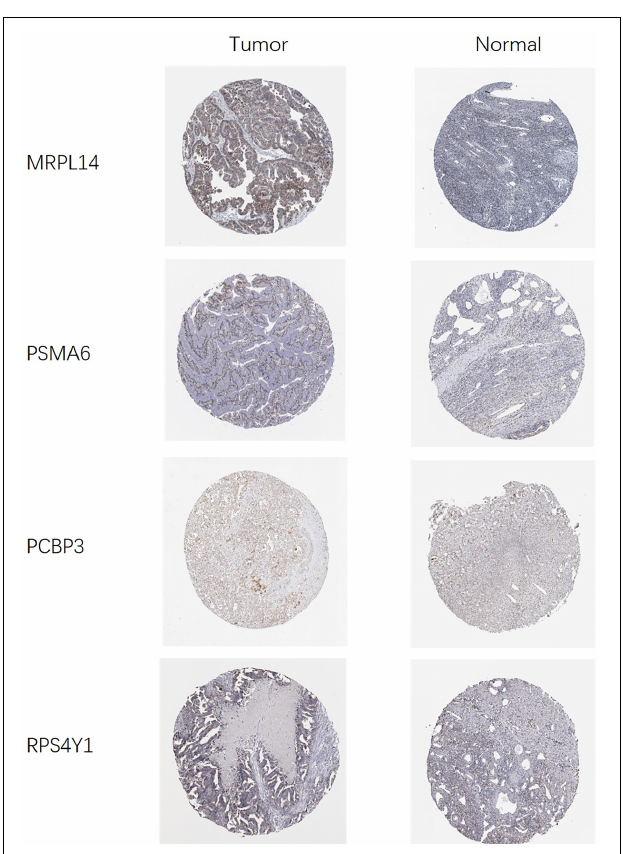
FIGURE 11 | Validation of prognostic RBP expression in OSC and normal ovarian tissue using the HPA database.